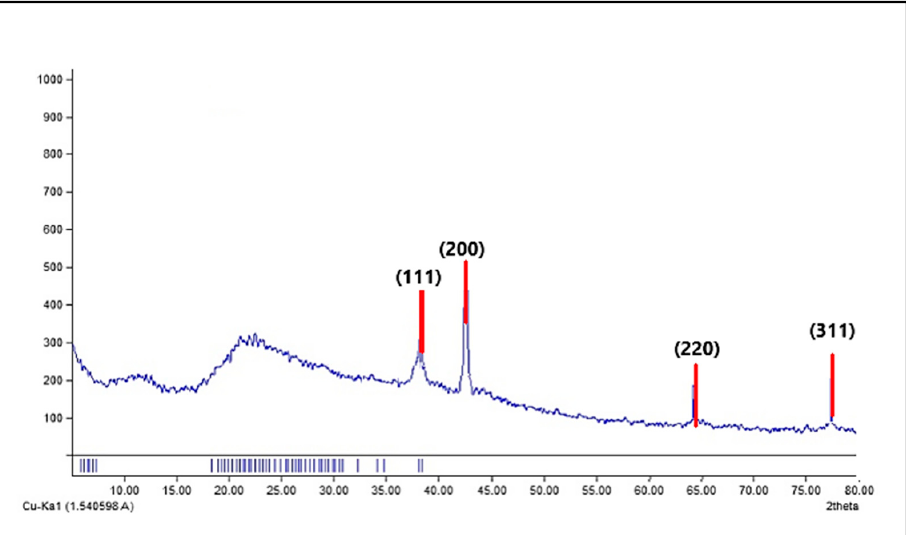
Figure 7. X-ray diffraction (XRD) pattern of the green synthesized AgNPs by